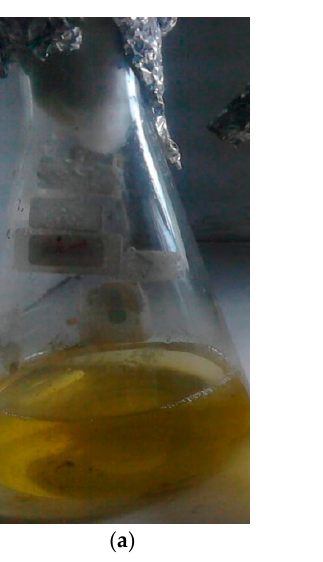
Figure 1. ( a ) Bacterial culture and ( b ) carotenoid extract of V. salarius strain 19 PPSc1.6 .